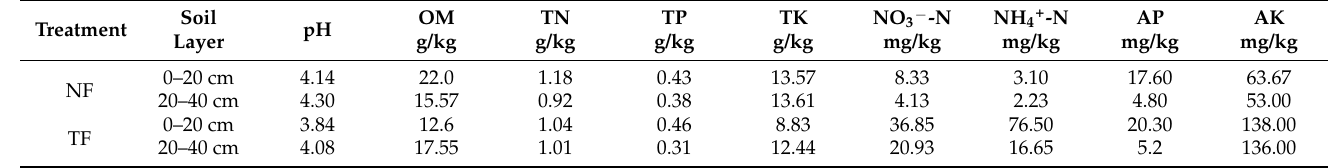
Table 3. The physical and chemical properties of soils with NF or TF